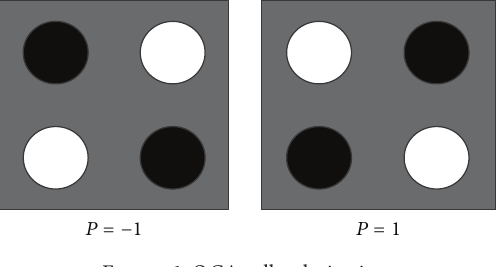
Figure 1: QCA cell